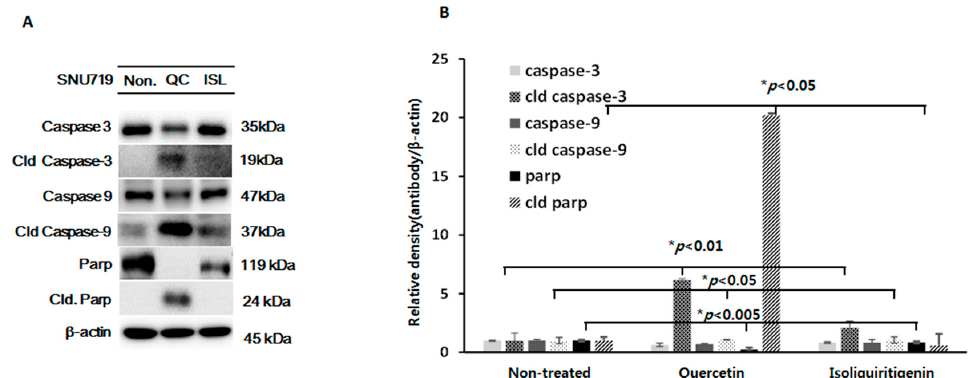
Figure 4. Expressions of (cleaved) caspase-3, -9, and (cleaved) Parp proteins in tumor tissues from mice implanted with EBV(+) human gastric carcinoma (SNU719)